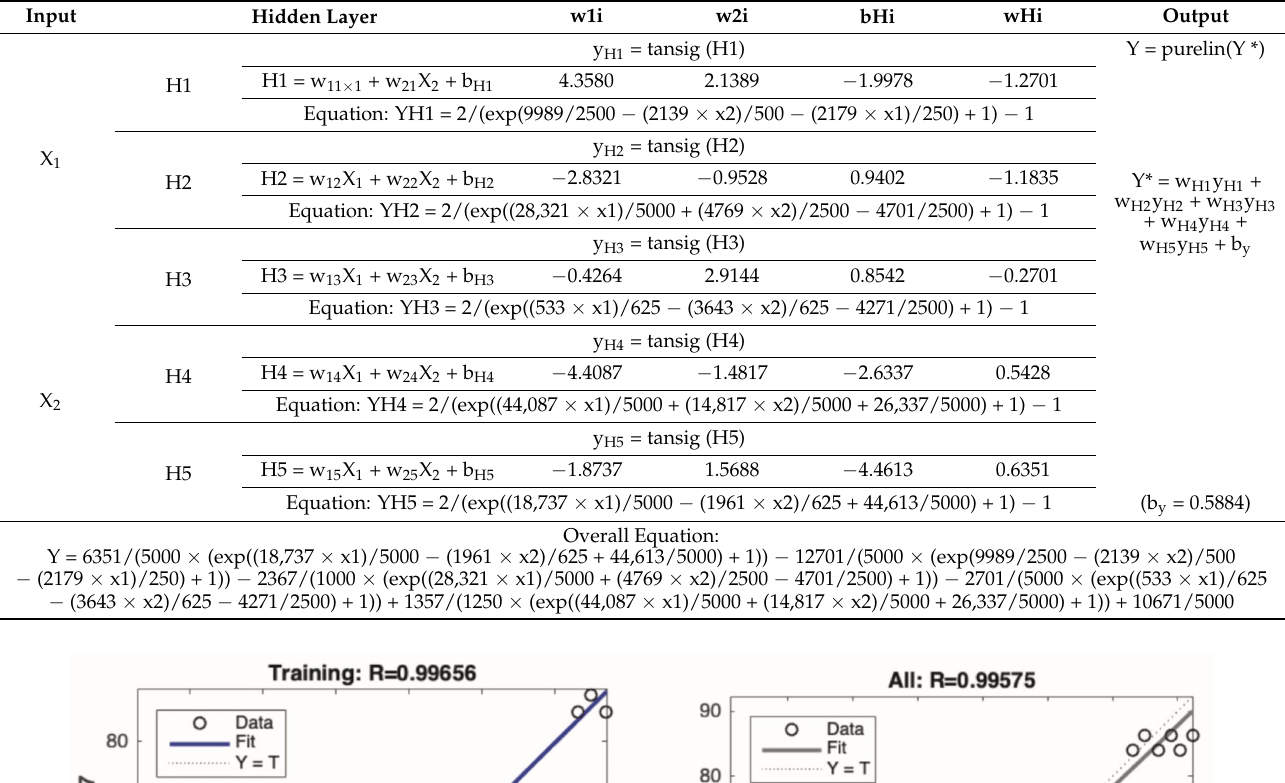
Table 13. Prediction equations used in ANN.